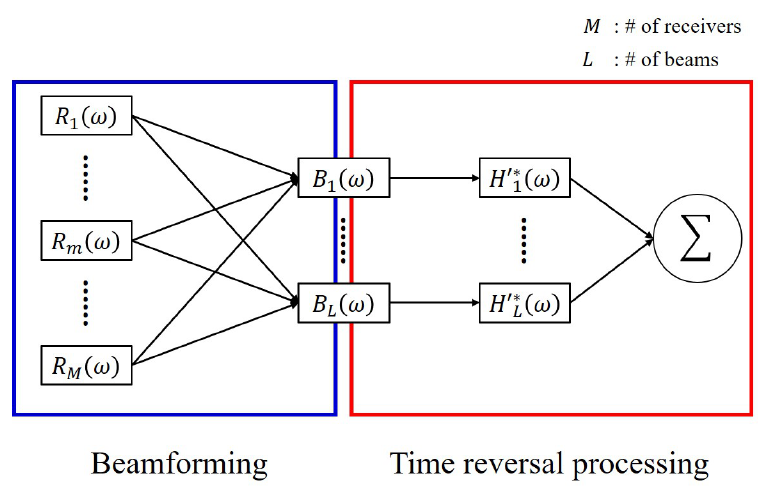
Figure 2. Block diagram illustrating time reversal processing using the beam diversity method. The beam diversity method has two processes: (1) beamforming the received signals (blue box) and (2) estimating the channel impulse response of the beamformed signal and using this response for time reversal processing (red